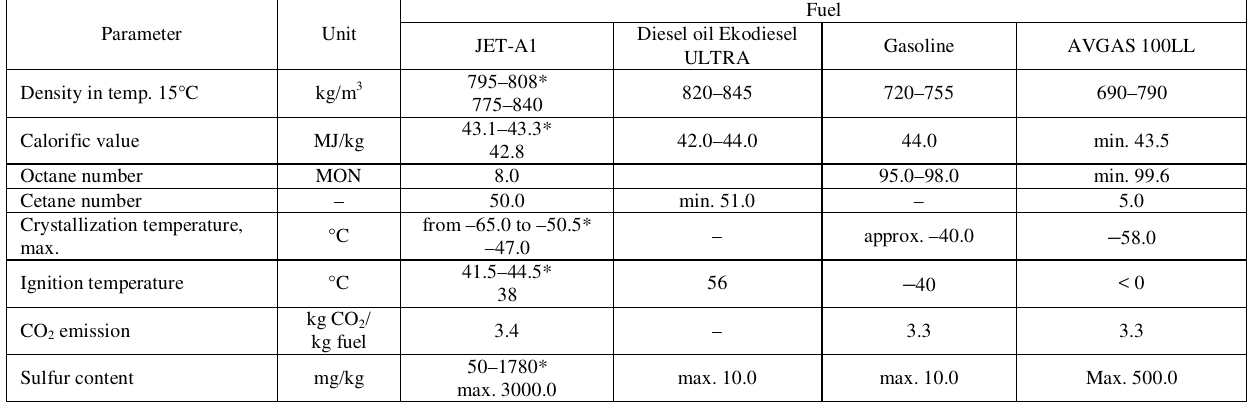
Table 1. Comparison of properties of selected liquid fuels (* – results of tests of JET-A1 fuels from 3 manufacturers) [3,6]